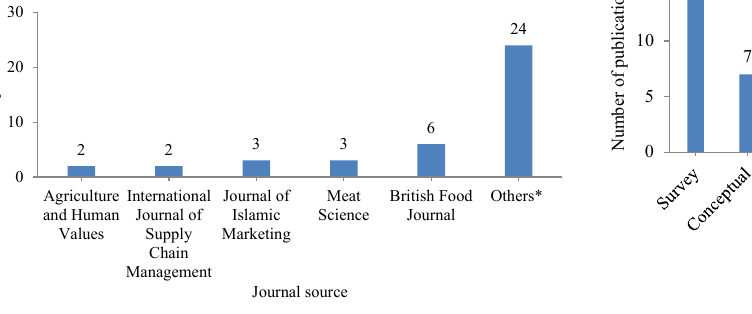
Figure 2 Journal source distribution Figure 3 Distribution based on research